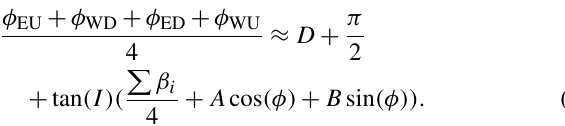
around horizontal axis of the theodolite, and ϕR z () is the ro- tation matrix around vertical axis of the theodolite. Consid- ering the following transformation, , the development of the first term of Eq. (1) leads to the Au- toDIF model (Eq.